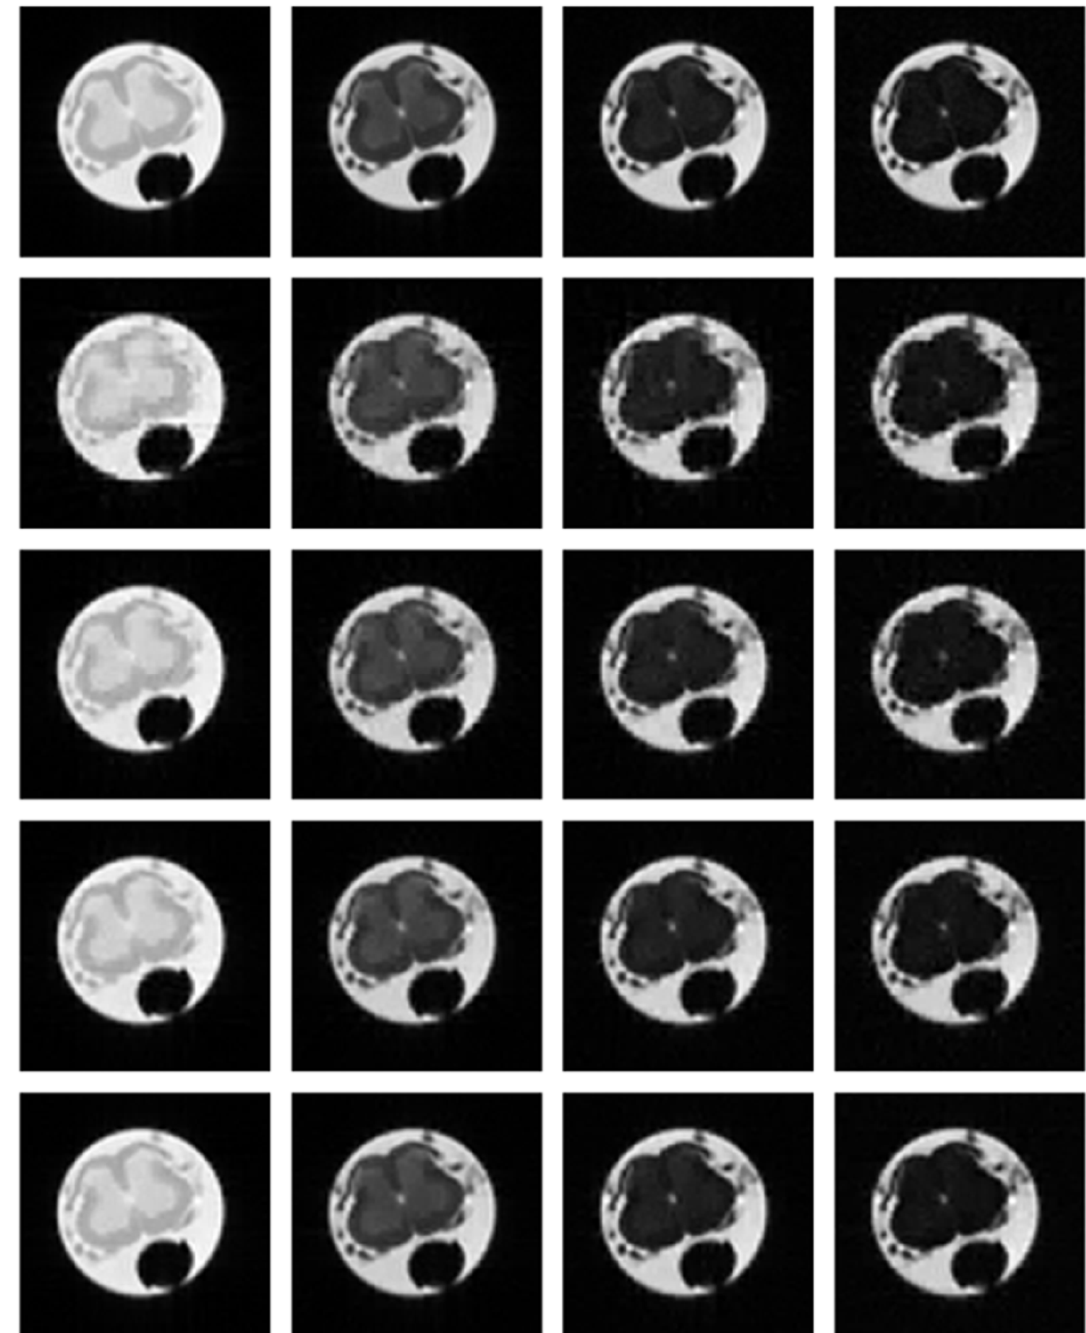
Figure 3. Images from ex vivo reconstruction. Top row—groundtruth; 2nd row—same sampling pattern, row-sparse recovery; 3rd row—same sampling pattern, rank-deficient row-sparse recovery; 4th row—different sampling pattern, group-sparse recovery; 5th row—different sampling pattern, rank-deficient group-sparse